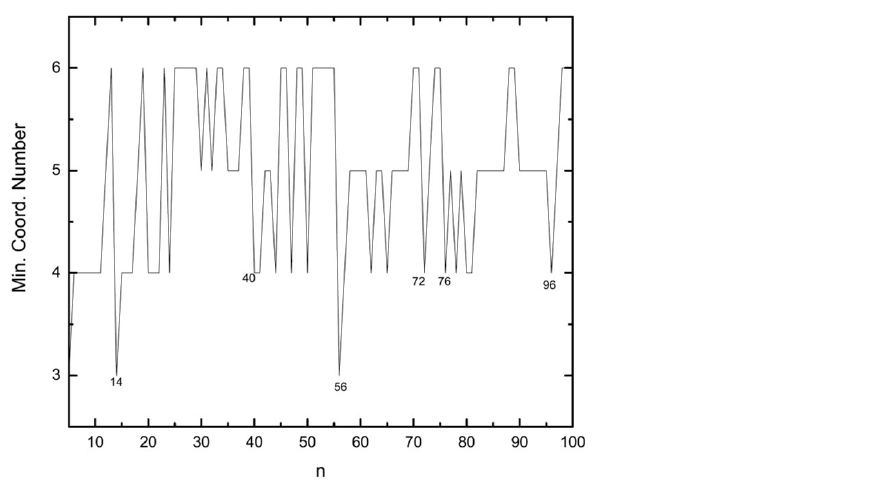
Figure 12. Minimum coordination number in each cluster size versus the number of